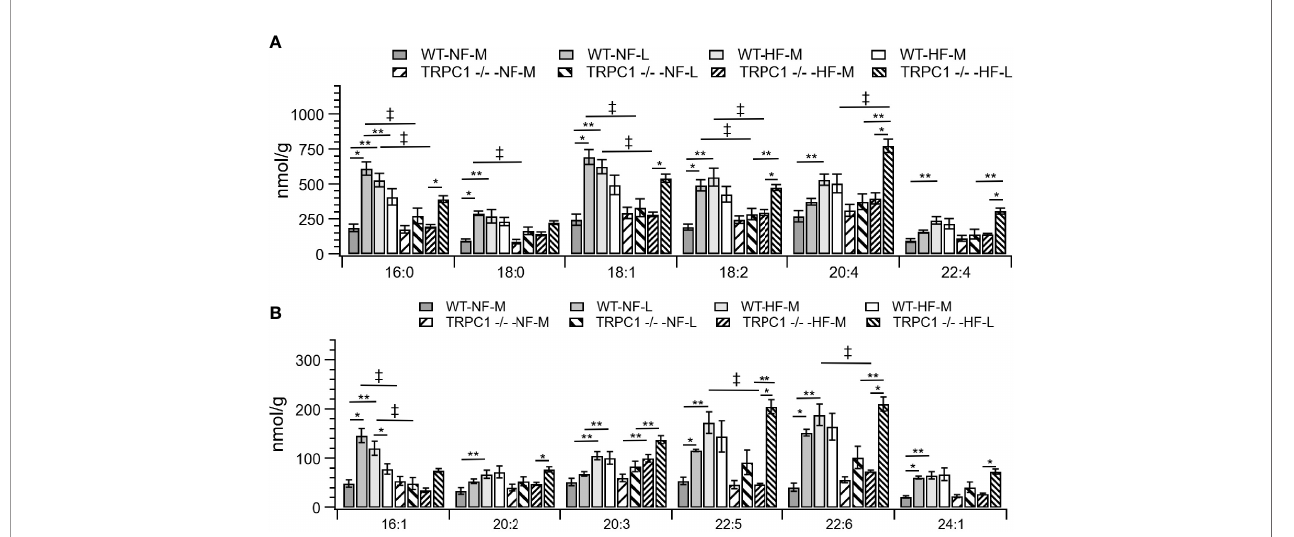
FIGURE 3 | PlacentalCE concentration by species for CE C:N. C = acyl carbon number and N = acyl desaturationlevel. Species are groupedwithconcentrationdecreasing from A to B to demonstrate the range of concentrations. Data are shownas mean ± sem (n = 16, except for HF-TRPC1 where n = 12). Symbols indicate differences with p<0.05 base uponone-wayANOVA withTukey ’ s HRD post hoc test and applicationof a 0.05 false discovery rate for gestational age (*), diet (**), and genotype ( ‡ ). P-values are available in Supplemental Materials . WT, wild-type; TRPC1 -/-, TRPC1 knock-out; NF, normal fat diet; HF, high-fat diet, M, mid-gestation; L, late gestation.